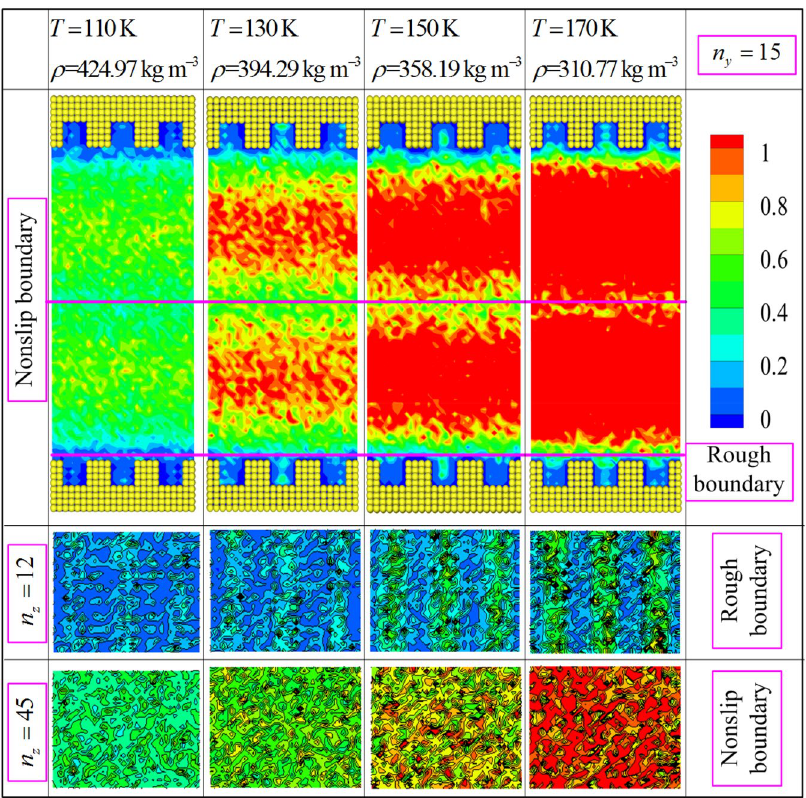
Figure 11. Translational energy (the unit of energy is ε ) contour plots for different state points using the mixture boundary Poiseuille flow